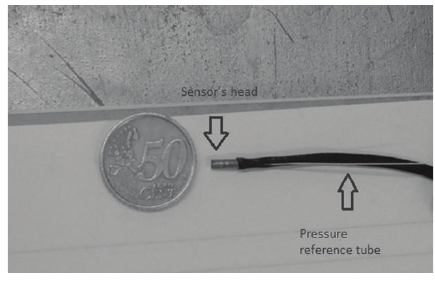
Figure 14: Pressure transducer.